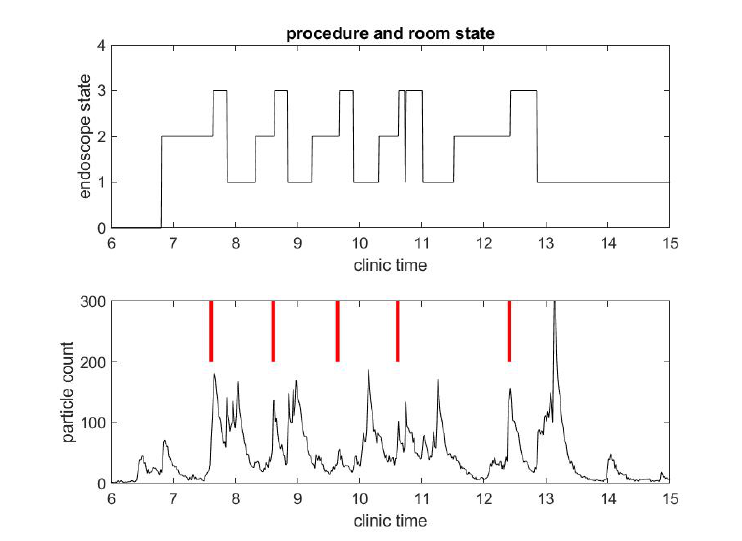
Figure 4. Example of small particle count during a clinical day in a procedural room. ( Top ) the endoscope state, 0 for endoscope tower not in use, 1 for endoscope tower powered on, 2 for endoscope plugged in but not in use during procedure preparation, and 3 for in use during procedure; and ( Bottom ) the small particle count only, with red bars marking when the procedure in ( Top )